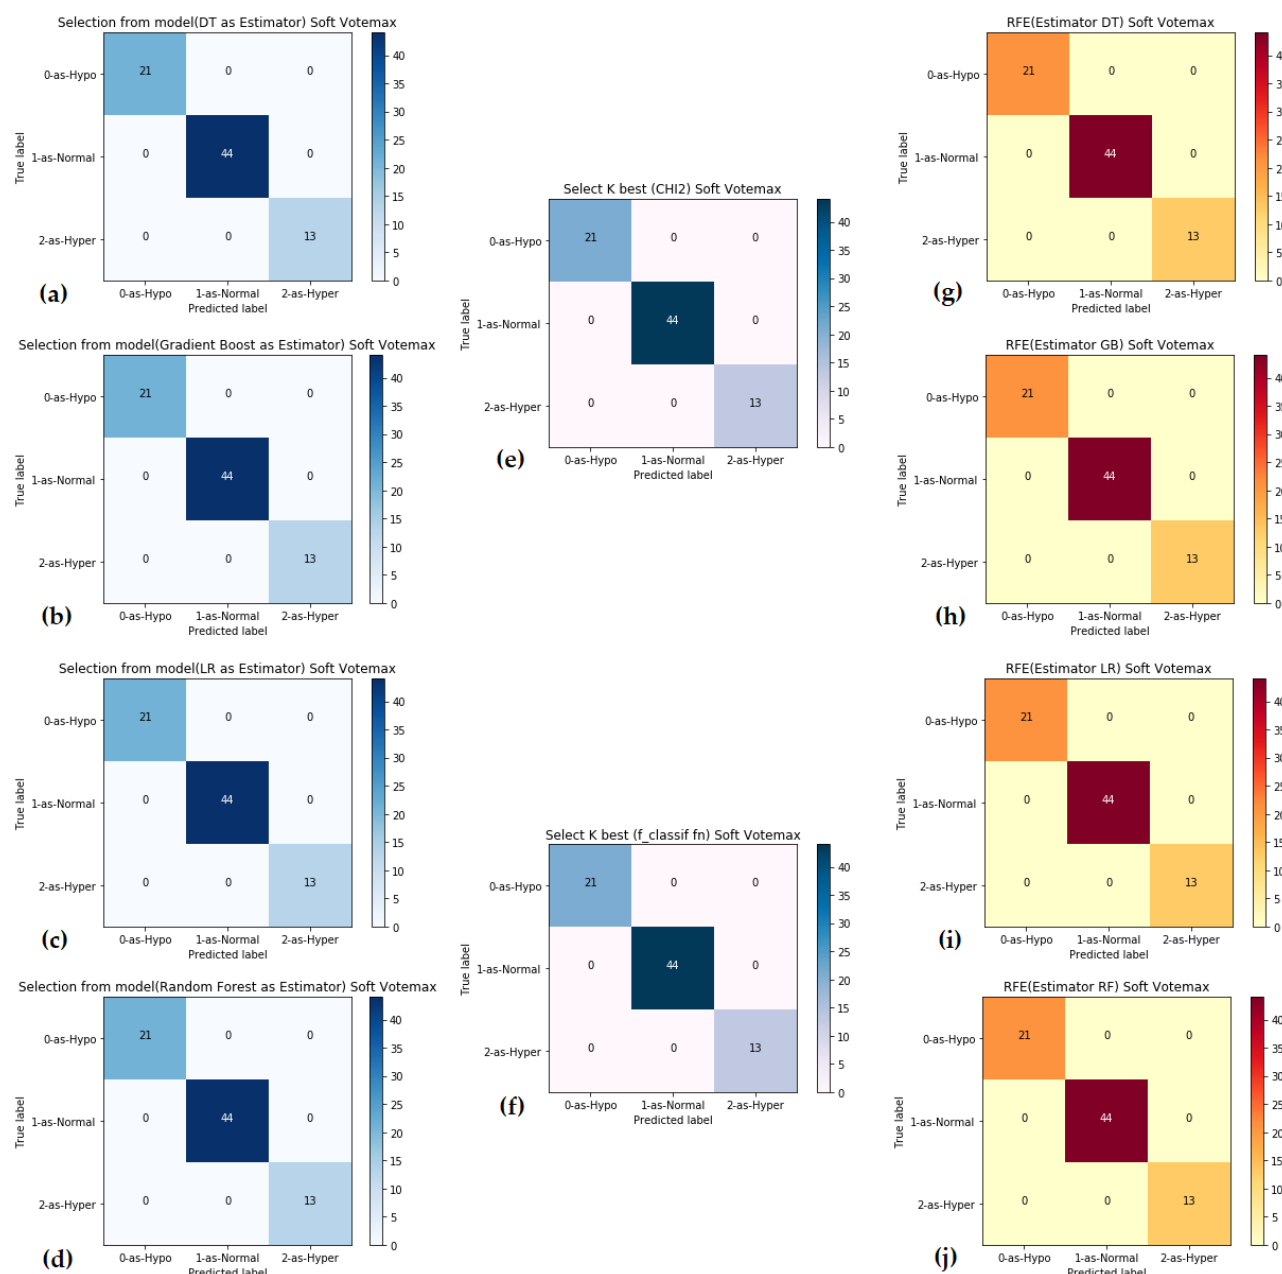
Figure 5. Confusion matrices for the soft voting ensemble of the bagging and boosting classifiers by implementing various attribute- selection methodologies with multiple estimators. ( a – d ) DT, GB, LR, RF estimators with SFM feature selection, ( e ) Chi2, ( f ) FCI with SKB feature selection, and ( g – j ) DT, GB, LR, RF estimators with RFE attribute selection, respectively.